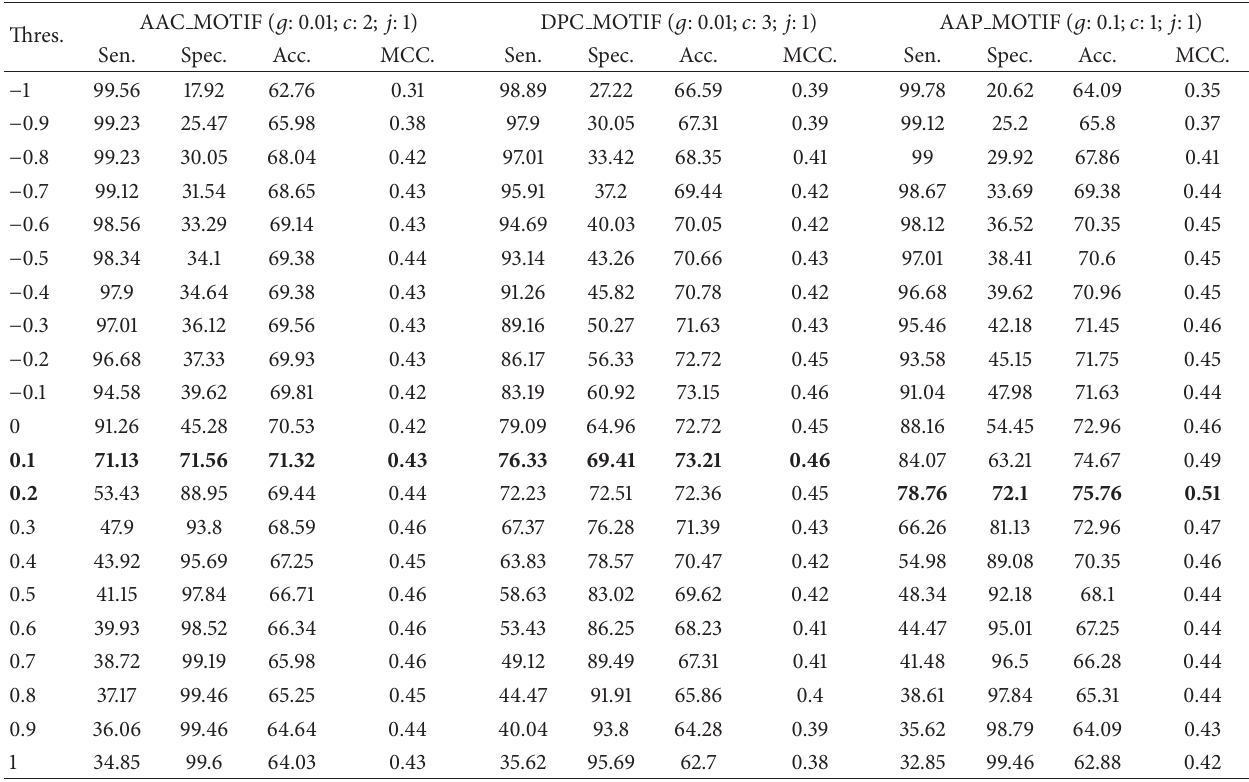
Table 4: The performance of hybrid models that combines motif based approach and SVM models developed using various compositional features of peptides on rbf-kernel. The optimized parameters have been given in the brackets. Thres.